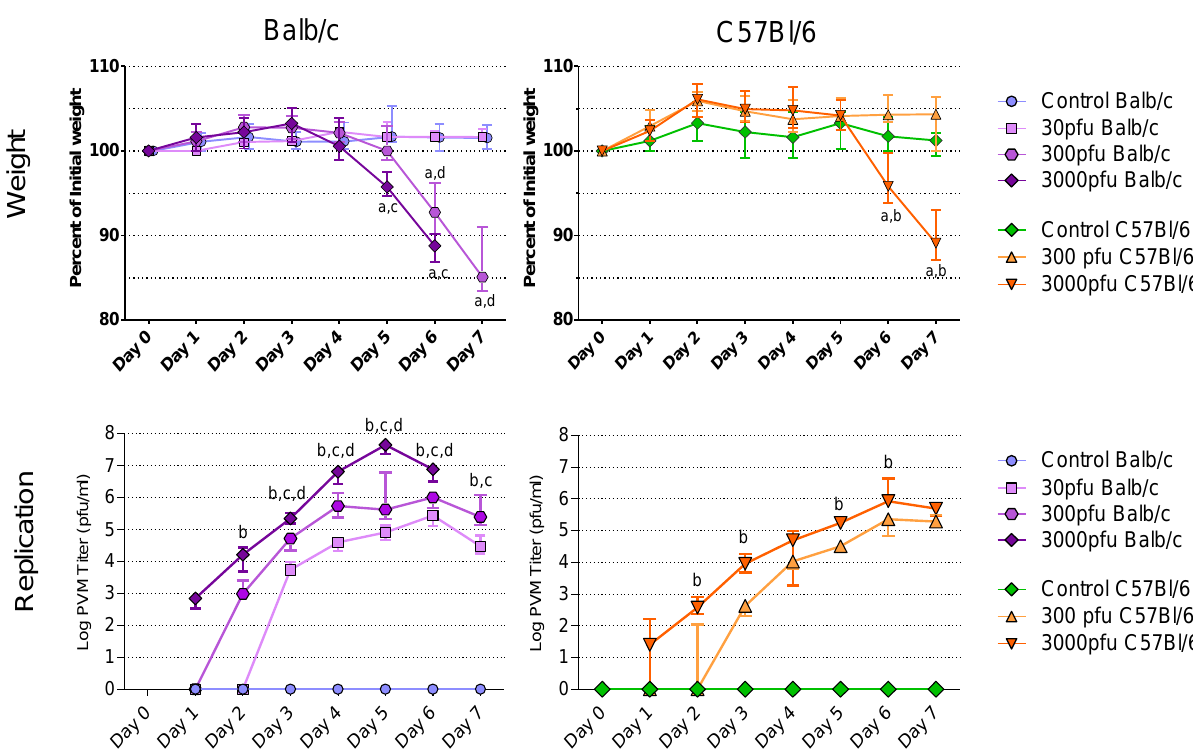
Figure 1. Weight loss and accumulation of virus in the lungs following infection with PVM 15 in Balb/c and C57Bl/6 mice. Five to six week-old Balb/c and C57Bl/6 mice were inoculated with medium, 30 pfu, 300 pfu, or 3000 pfu of PVM 15 and weighed daily for 7 days following infection, and 4 mice per group were sacrificed daily. (A-B) median weight for each group, expressed as a percentage of the starting weight, with error bars indicating the interquartile range. (C-D) median viral load for each group with error bars indicating the interquartile range. a: p <0.05 compared to control group; b. p <0.05 between 3000 and 300 pfu; c: p <0.05 between 3000 and 30 pfu; d: p <0.05 between 300 and 30 pfu. Differences in virus replication with the control groups are not